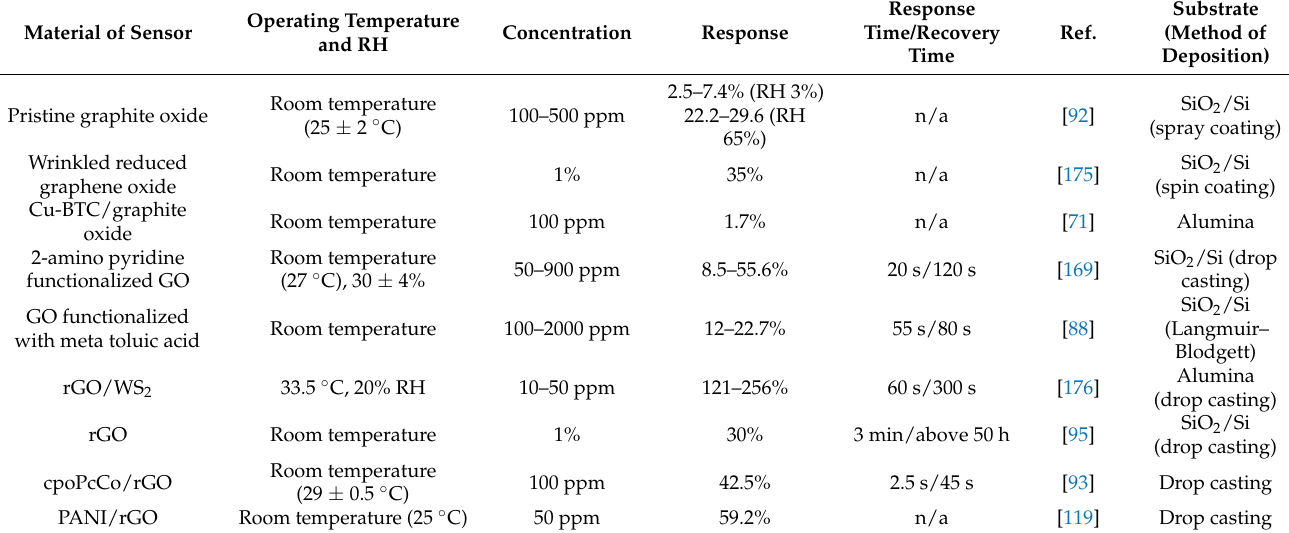
Table 2. Characteristics of ammonia gas sensors based on graphene, graphene oxide (GO), and related materials. Material of